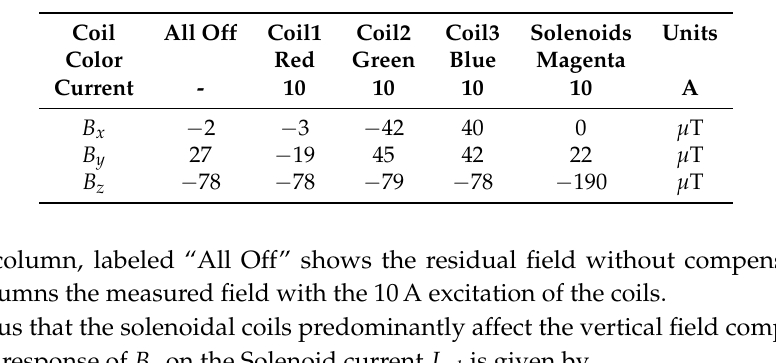
Table 1. Magnetic fields caused by passing 10A through the coils, one at a